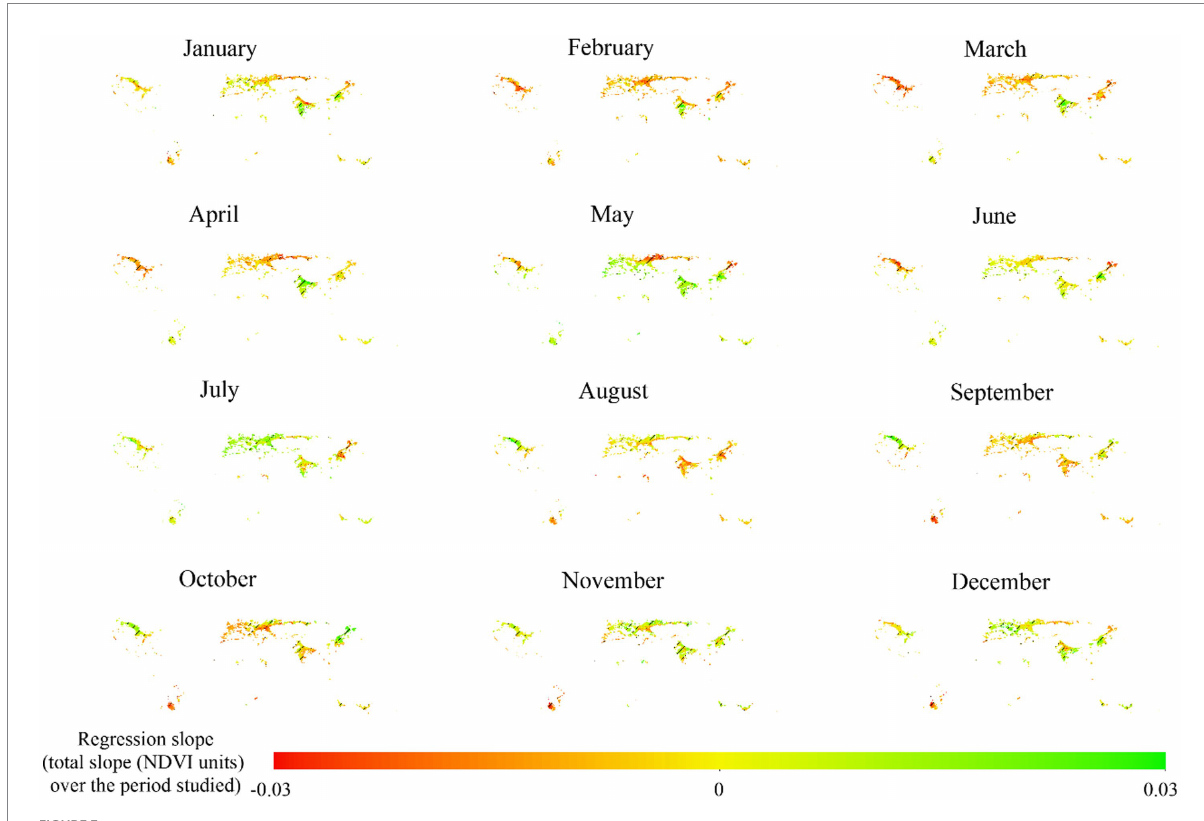
FIGURE 3 Variation of global grassland NDVI from 1981 to 2015 (slash represents the MK test passing 95% confidence